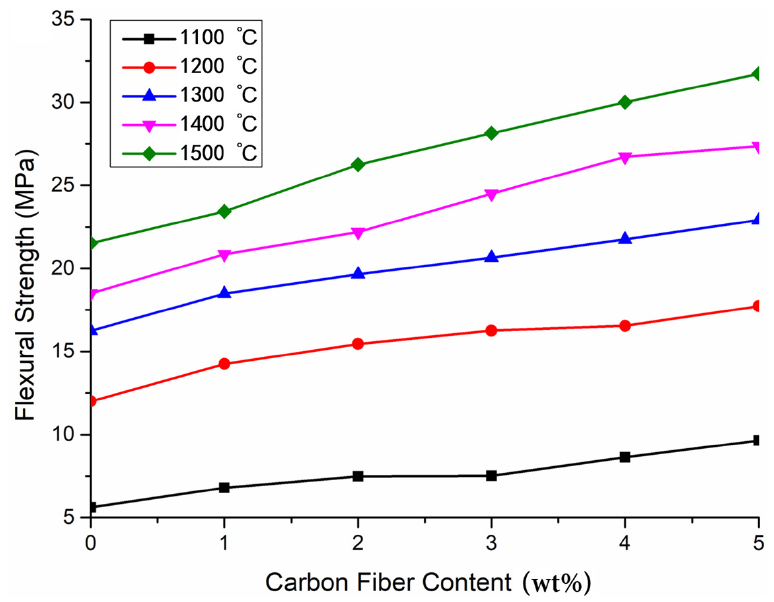
Figure 4. Bending strength of ceramic-fiber-reinforced materials at different sintering temperatures.